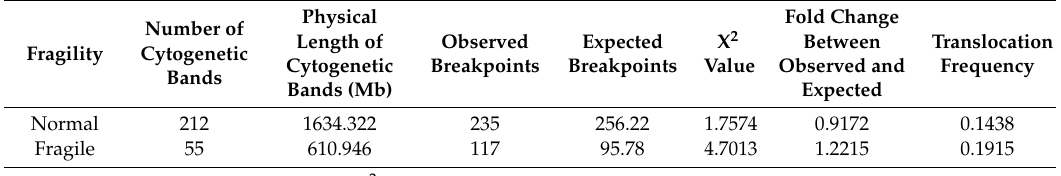
Table 7. Comparison of translocation breakpoints on cytogenetic bands with common fragile sites and normal